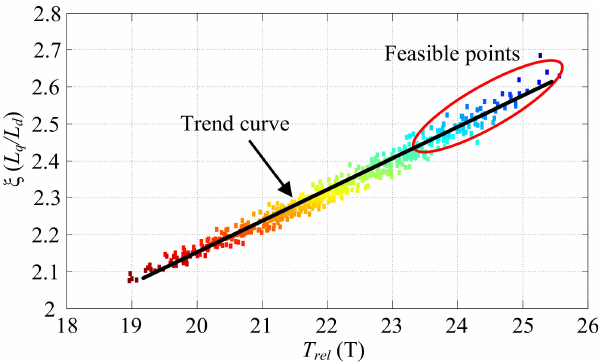
Figure 6. The tradeo ff between rotor saliency ratio and reluctance